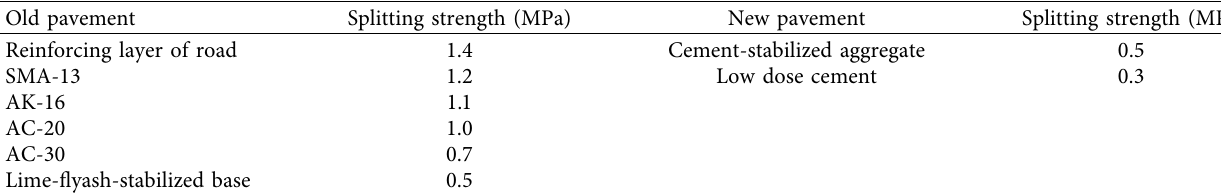
Figure 19: Maximum tensile stress at the bottom of the subbase. Table 5: Splitting strength of the pavement